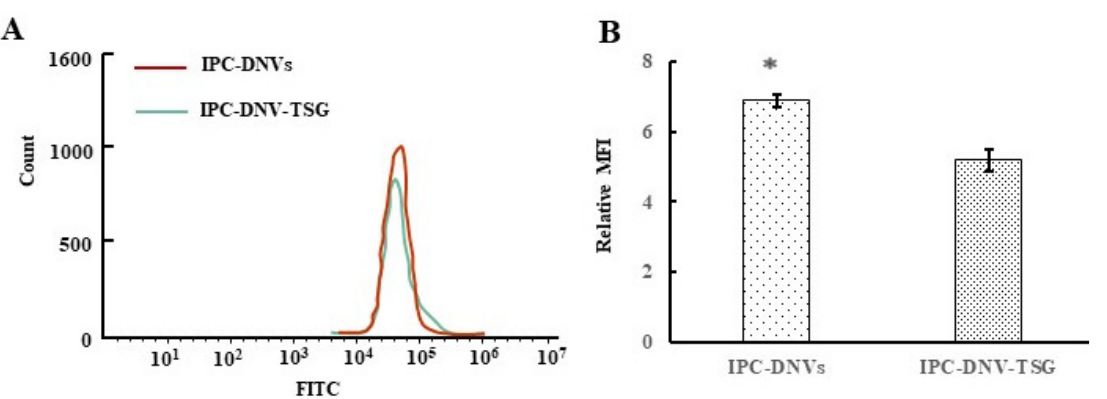
Figure 6. ( A ) Cellular uptake of IPC-DNVs and IPC-DNV-TSG in TR146 cells. ( B ) Relative mean fluorescence intensity (MFI) values of IPC-DNVs and IPC-DNV-TSG. * p < 0.05 between IPC-DNVs and IPC-DNV-TSG.